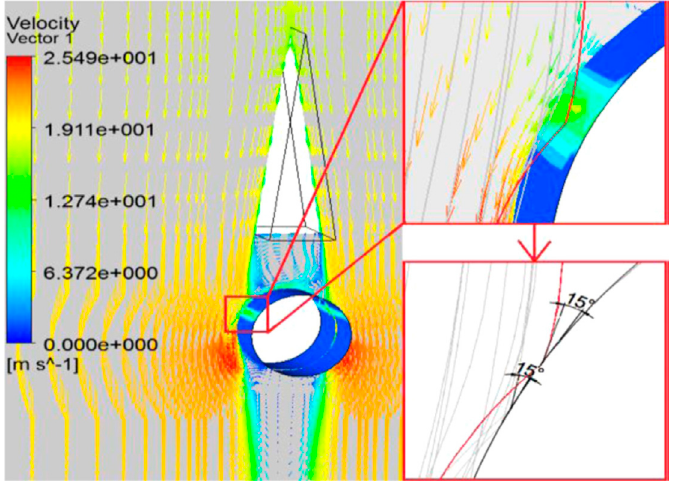
Figure 19. Velocity profile and sand particles angle of attack on the sample with 15° Cavitation Inducers (CI) and 3500 rpm in the tribometer [46].